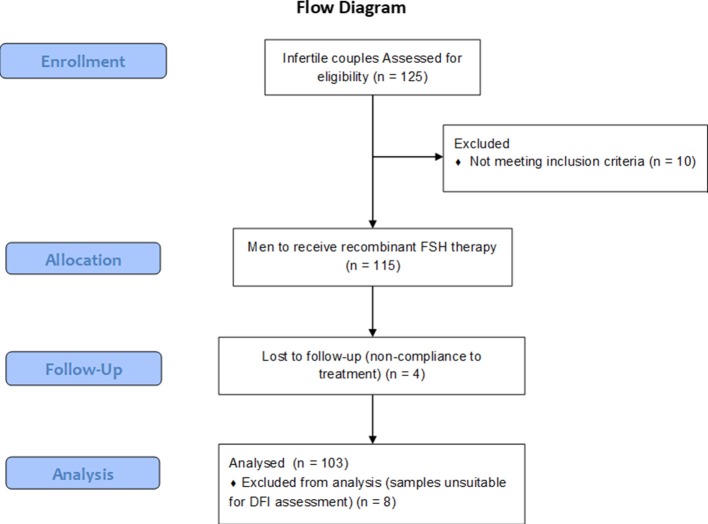
Study flowchart.